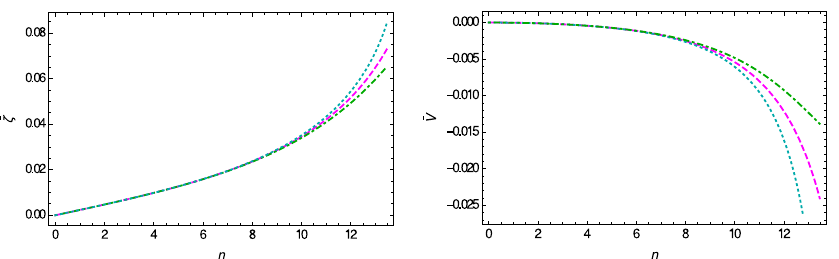
(cid:3) (cid:2) ¯ ζ and ¯ b = 0 . 033 (dot-dashed curve). For the central density of the (right panel) as func- star we adopt the value ρ mc = 3 . 7 × 10 14 g / cm 3 , while ¯ ζ 0 = 0 and ¯ ζ (cid:13) = 7 × 10 − 3 , respectively 0